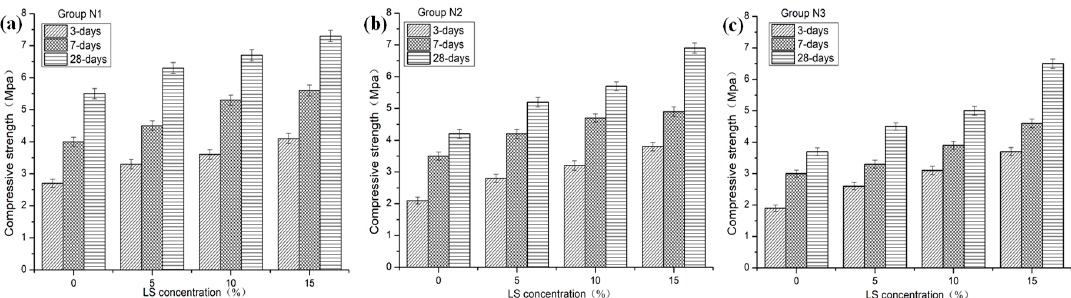
Figure 5. E ff ect of LS on compressive strength of NHL-based mortar: ( a ) Group N1, ( b ) group N2, and ( c ) group N3.